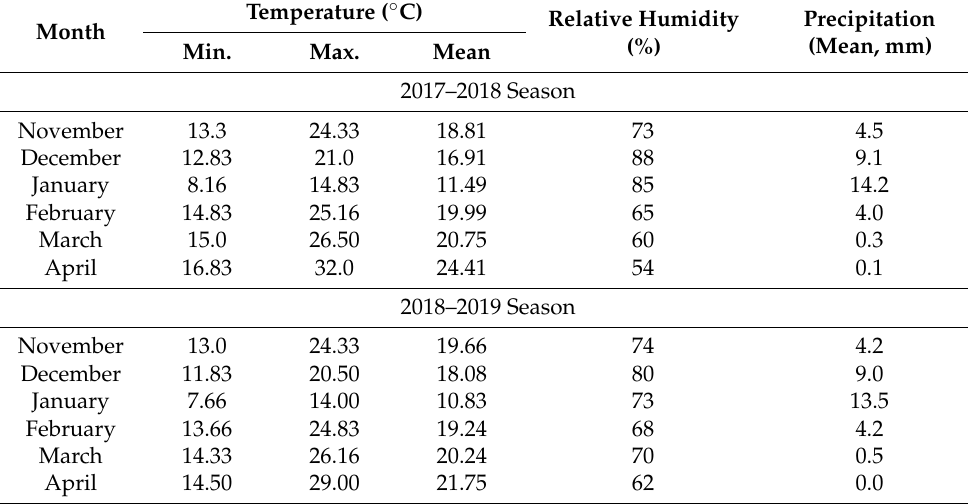
Table 2. Monthly mean minimum and maximum air temperatures ( ◦ C), relative humidity (%) and precipitation during the two wheat-growing